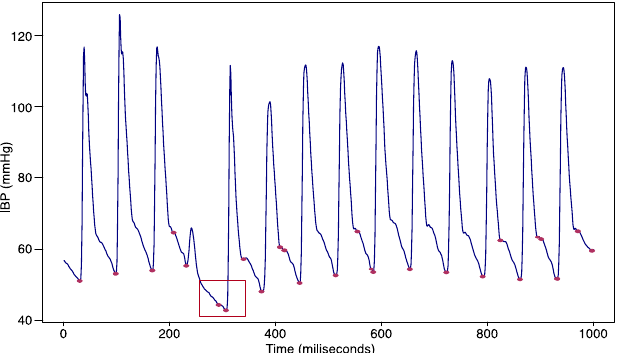
Figure 3. Downward peaks detected with a certain threshold.